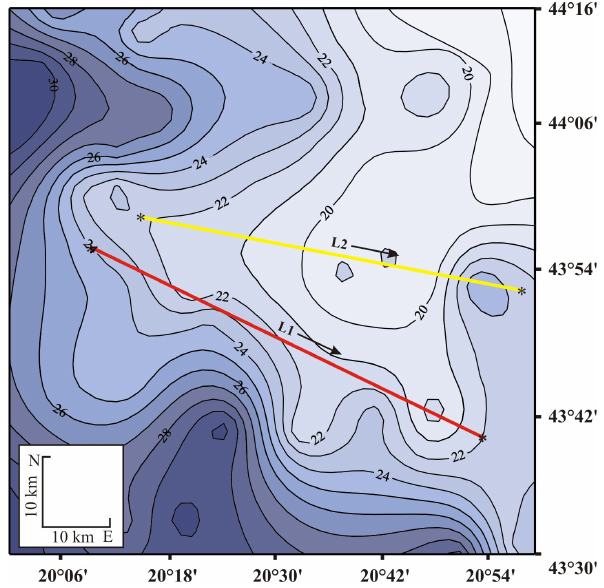
Fig. 2. Spatial distribution of the mean convective precipitation (in mm) at the surface for the study area in Fig. 1. Precipitation is represented by isohyets with an icrement of 1mm. The L1 and L2 represent the most frequent tracks of the splitted storms from the NW direction.